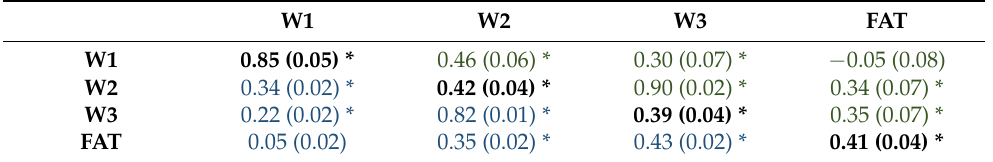
Table 3. Genetic parameters for body weight at different growth stages and fat content. Heritability is on the diagonal in bold; genetic and phenotypic correlations are above (in green) and below (in blue) the diagonal, respectively. Standard errors are illustrated in the parentheses.